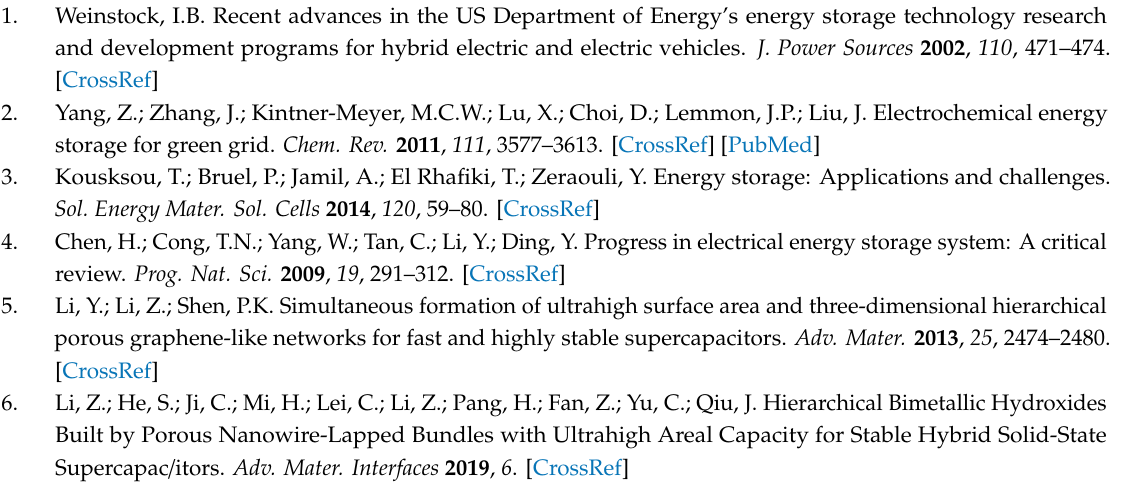
Figure S1: The long-term endurance test of DE-TENG for 1